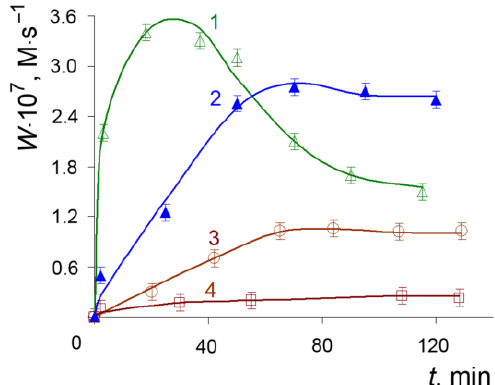
Figure 3. Dependence of oxygen consumption rate on time during the oxidation of adrenaline in phosphate buffer. [AAPH] = 4·10 − 3 M; [Adr] 0 = 1·10 − 3 M, pH = 9.0 (1), 8.2 (2), 7.4 (3), 6.0 (4); 310 K